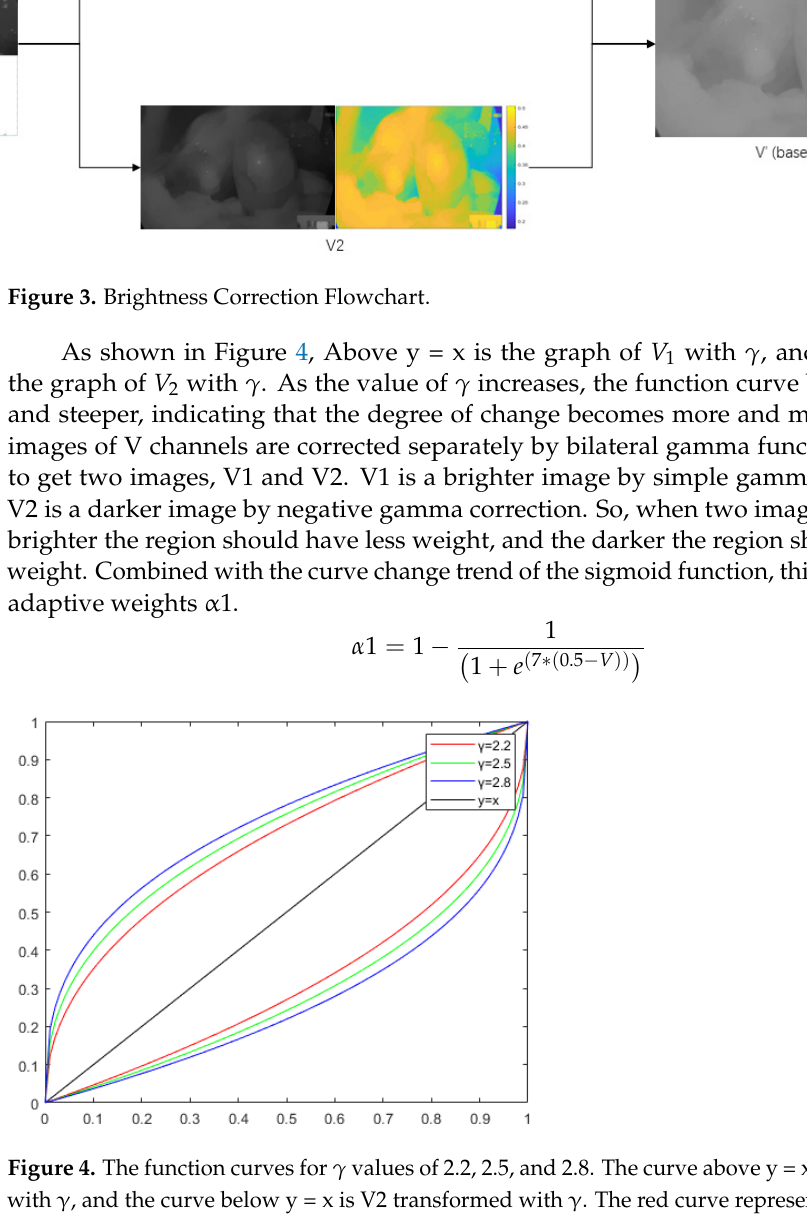
(14) Step4: The optimal parameter of γ is selected after comparison. The optimal parameter of γ is 2.2 when applied to the endoscopic image dataset, ob- tained by computational comparison.